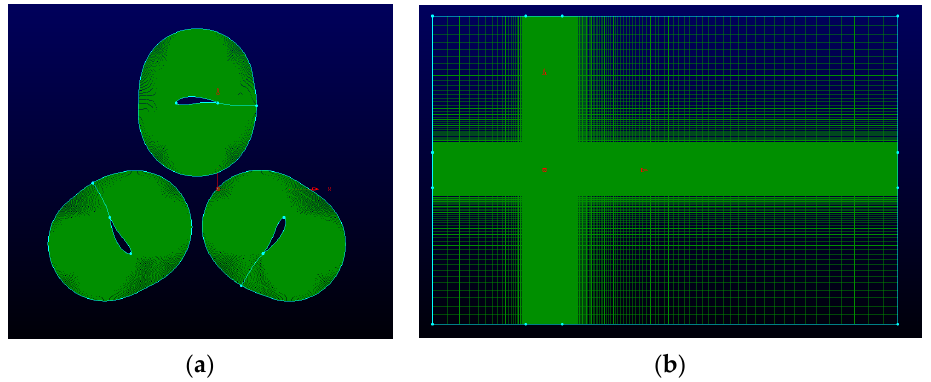
Figure 4. Meshes used in OM ( a ) Near body, ( b ) Background mesh. Table 4. Meshes used in the convergence analysis (OM).